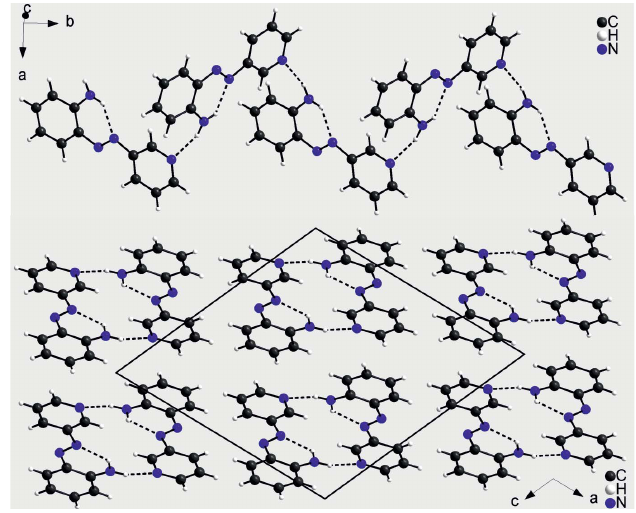
Figure 2 Crystal structure of the title compound showing a chain (top) and a view along the b axis (bottom). Intra- and intermolecular hydrogen bonds are indicated by dashed lines.